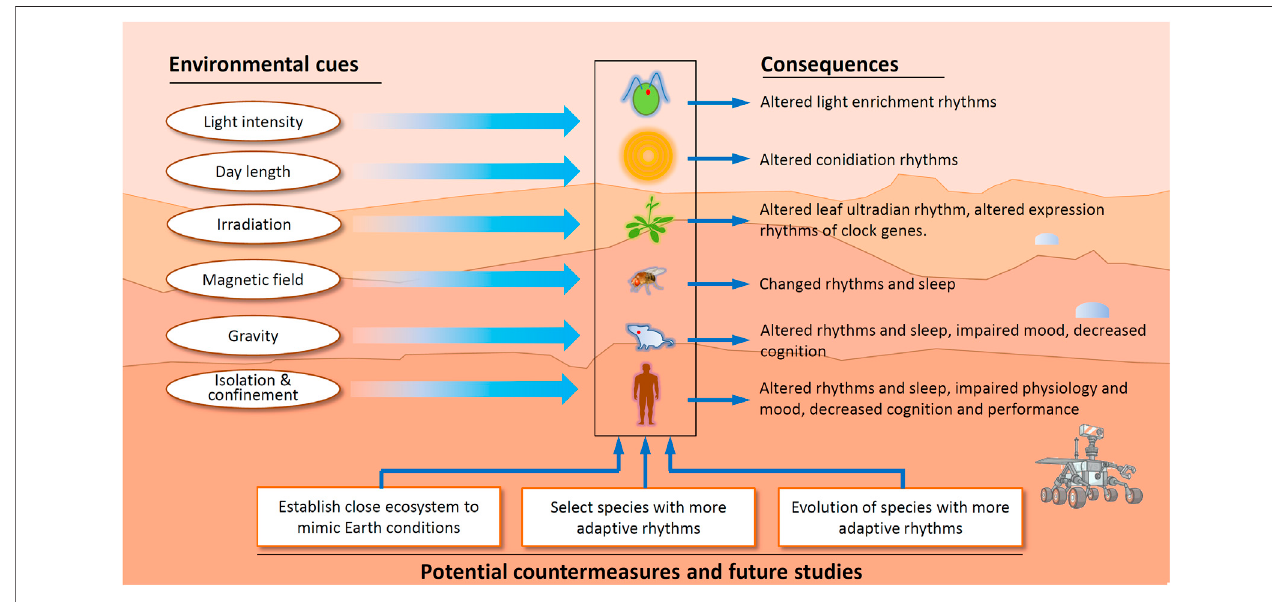
FIGURE 2 | Martian factors with effects on the circadian clock and strategies for future investigation and improvement of circadian rhythms in representative species. C. rheinhardi , N. crassa , Arabidopsis, mouse and human are depicted in the central column (Sulzman et al., 1984; Mergenhagen and Mergenhagen, 1989; Mallis and DeRoshia, 2005; Guo et al., 2014; Ma et al., 2015; Agliassa and Maffei, 2019; Kandarpa et al., 2019; Zhang et al., 2021).